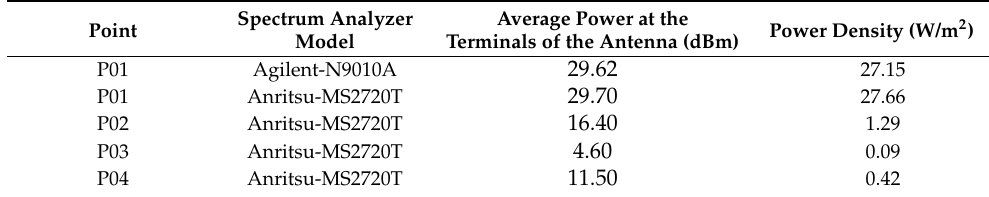
Table 3. Field Power Measurement and Computed Power